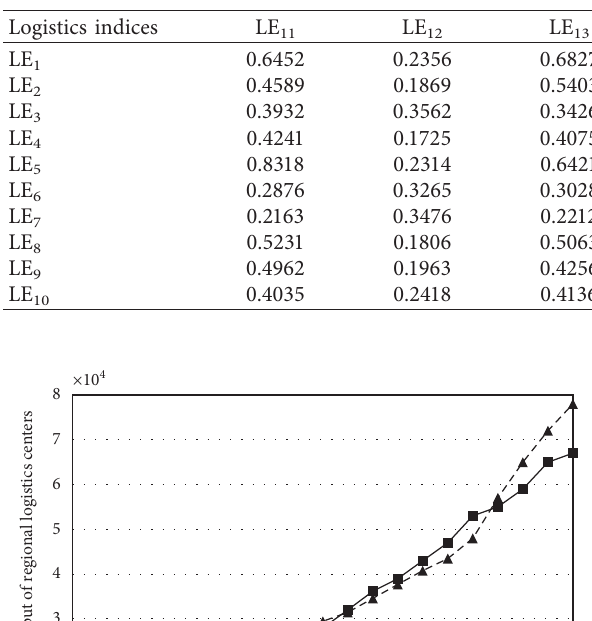
Table 1: Grey correlations between regional logistics and economy.